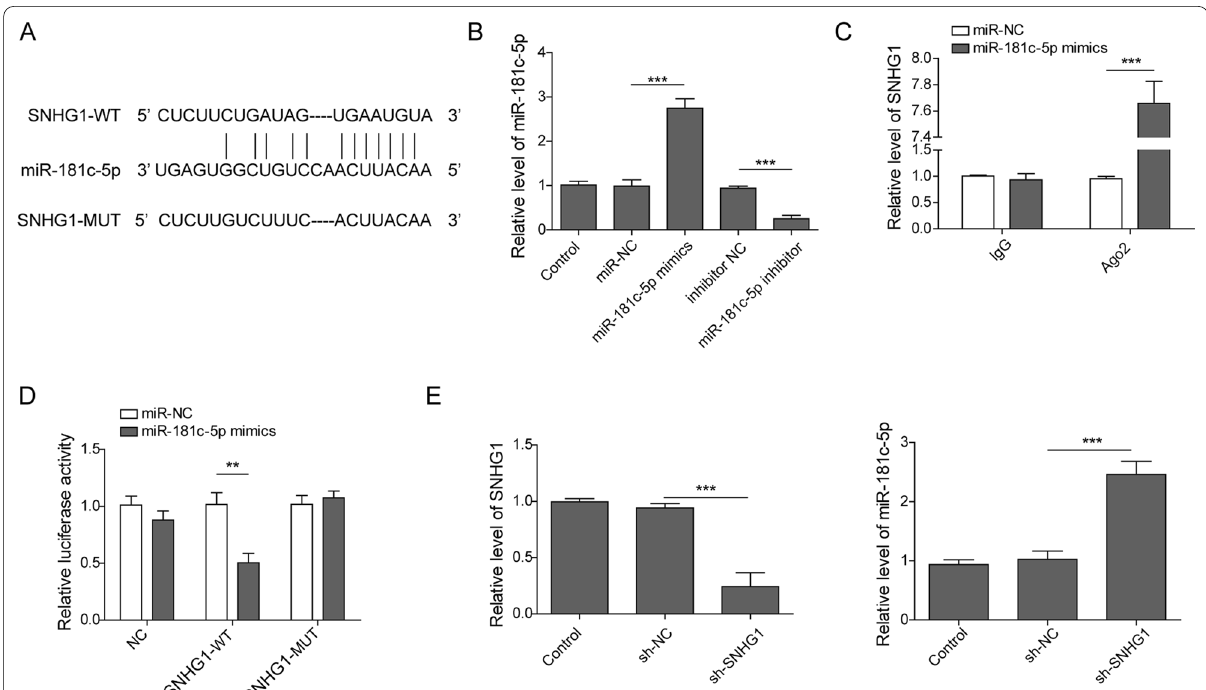
Fig. 2 LncRNA SNHG1 served as a sponge for miR‑181c‑5p. A starBase analysis showed the potential binding sites for SNHG1 and miR‑181c‑5p. B The BMSCs were transfected with miR‑181c‑5p mimics, miR‑181c‑5p inhibitor or their negative controls for 48 h, then the level of miR‑181c‑5p was measured suing qPCR. C The RIP assay performed to determine the interaction between SNHG1 and miR‑181c‑5p in BMSCs. D Luc‑SNHG1‑WT or Luc‑SNHG1‑MUT plasmids were co‑transfected with miR‑181c‑5p mimics or negative control for 24 h, the luciferase activities in each group were measured. E The BMSCs were transfected with sh‑SNHG1 or sh‑NC, then the relative levels of SNHG1 and miR‑181c‑5p were measured through qPCR. ** P < 0.01, *** P <